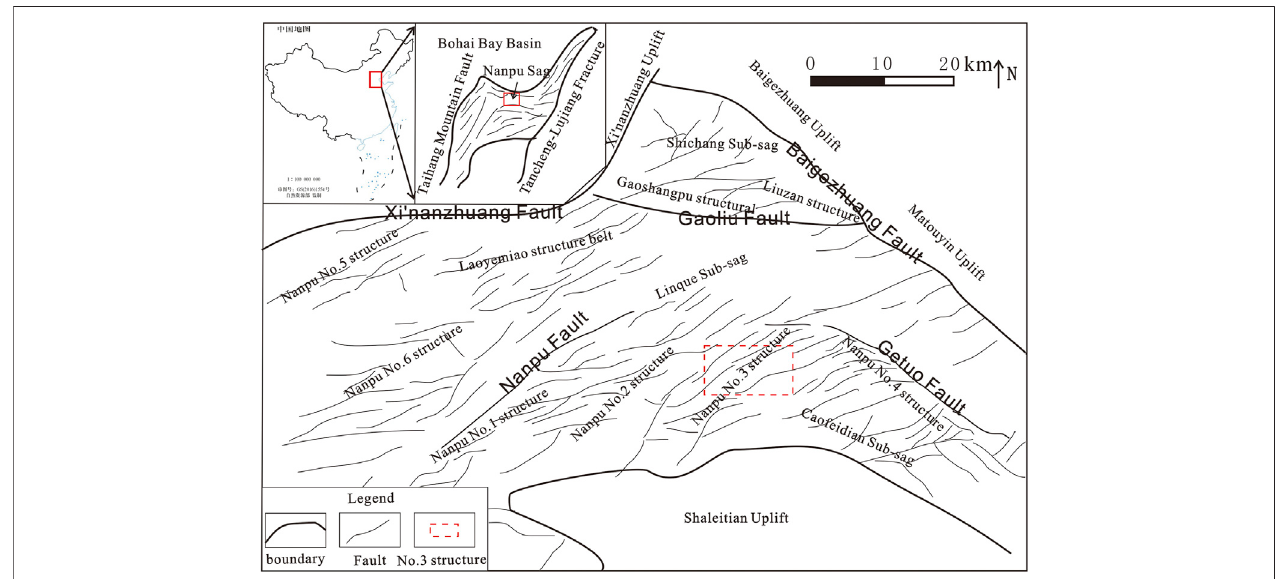
FIGURE 1 | Structural location diagram of the Nanpu No. 3 structural